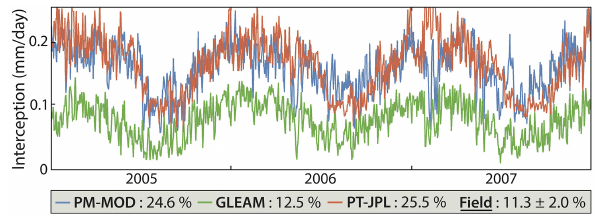
Figure 13. Interception loss in Amazonia. Daily time series of in- terception (mmday − 1 ) for 2005–2007 from the three WACMOS- ET products as averaged for the entire Amazon Basin. The aver- age interception (as percentage of rainfall) from the three models is listed, together with the mean ( ± 1SD – 1 standard deviation) of past field campaigns by Lloyd et al. (1988) ( ± 1 SD), Czikowsky and Fitzjarrald (2009) (11.6%), Ubarana (1996) (11.6%), Cuartas et al. (2007) (13.3%), Marin et al. (2000) (13.5%), and Shuttle- worth (1988) (9.1%). See Fig. 1 for the Amazon catchment bound- aries and the locations of the field